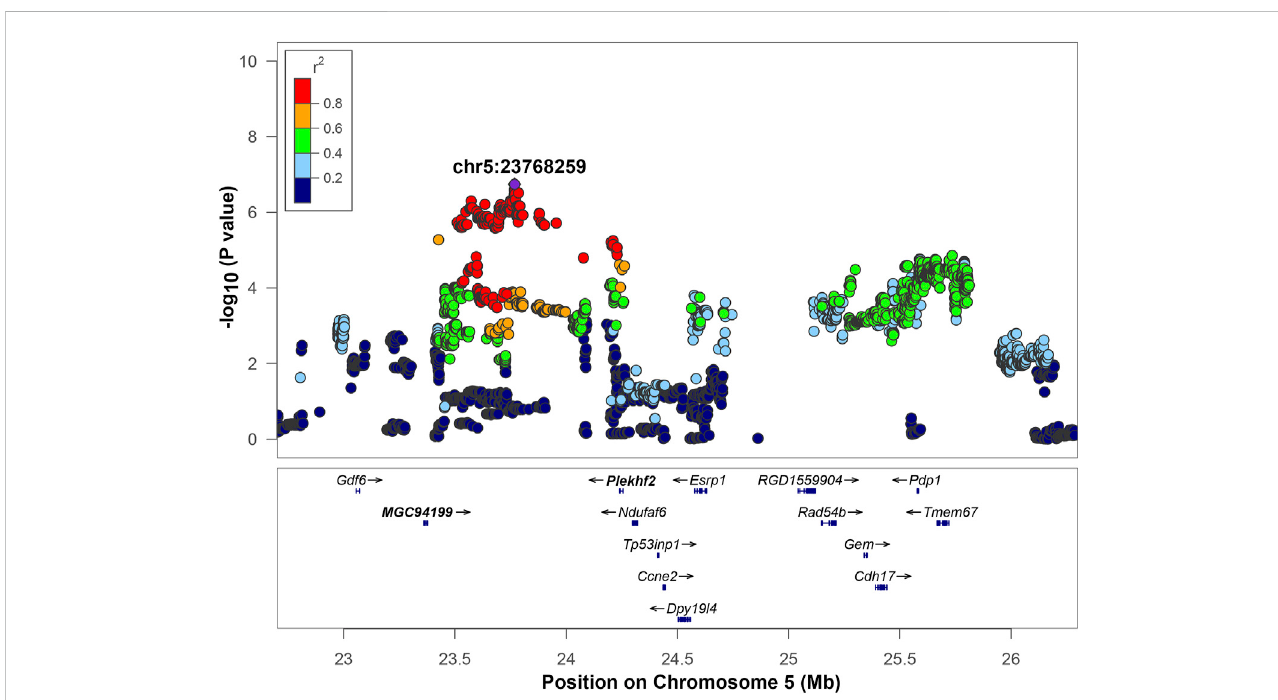
FIGURE 4 Regionalassociation plotfor QTLon chromosome 5. The x -axisshowsthechromosomal position. The SNP withthelowest p -value( “ topSNP ” )is shown inpurple,anditschromosomalpositionisindicatedontheplot.Thecolorofthedotsindicatesleveloflinkagedisequilibrium(LD)ofeachSNPwiththetopSNP, as measuredby correlation.The bottompanel indicates thegenesin theregion,as annotatedby theNCBIReference Sequence Database.*The Ndufaf6 gene liesoutsideoftheinterval ofhighLD (r 2 > 0.6).Genesthatare bolded( MGC94199 and Plekhf2 )are locatedin theinterval of highLD ofthetop SNP based on an r 2 > 0.6